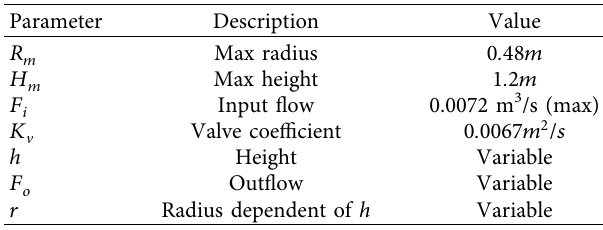
Figure 15: Considered shape for f